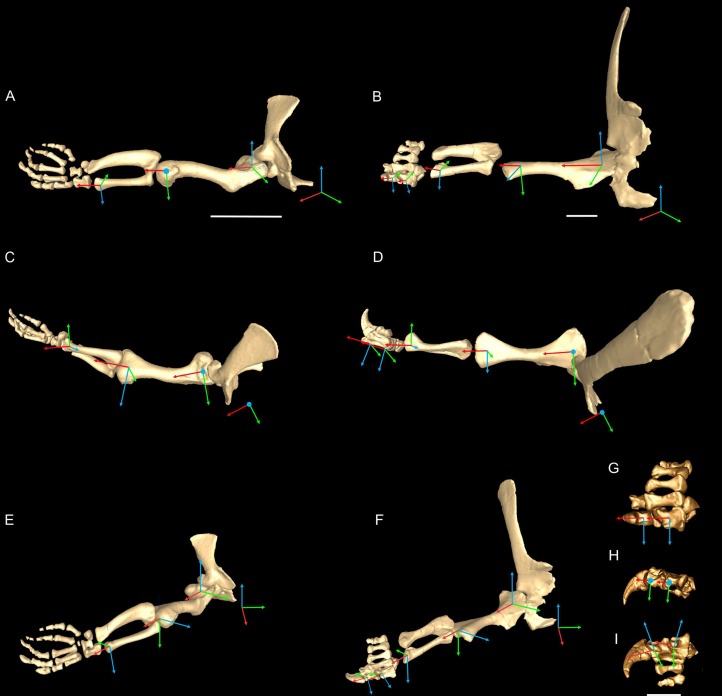
Crocodylus and Mussaurus models.Joint axes for rotation (x, y, z) in the reference pose showing the whole forelimb (A–F) and manus (G–I) in cranial (A, B), dorsal (C, D, G), craniolateral (E, F), medial (H) and ventromedial (I) views. (A, C, E) are Crocodylus and (B, D, F–I) are Mussaurus. Joint axis ‘x’ (red) corresponds to pronation/supination; ‘y’ (green) corresponds to adduction/abduction; and ‘z’ (blue) corresponds to extension/flexion, based on the coordinate system described by Baier & Gatesy (2013).